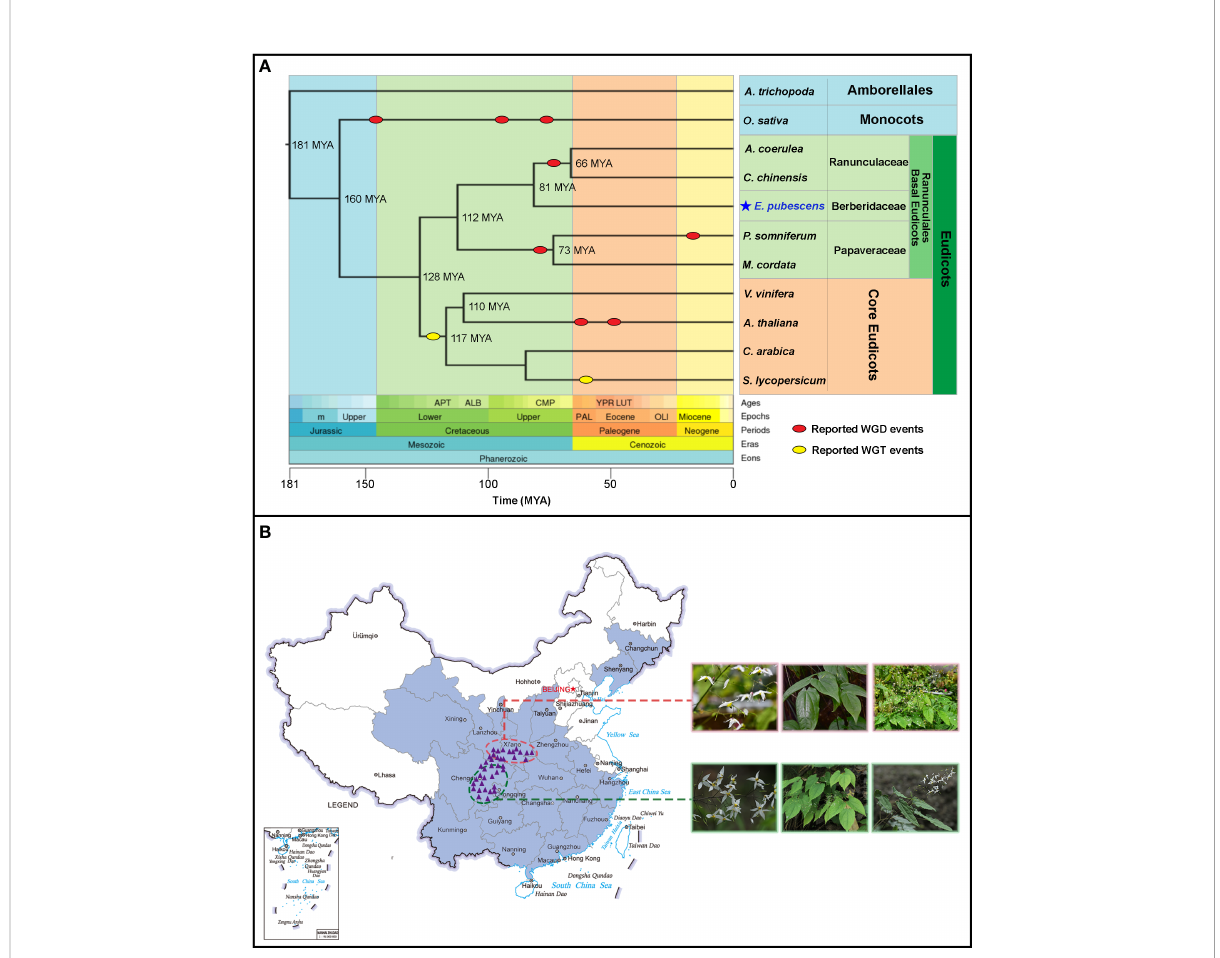
FIGURE 1 The phyologentic position of E . pubescens from Timetree website and the geographical distributions of Epimedium and E . pubescens in China. (A) Timetree of selected taxonomic groups in angiosperm. Whole Genome Duplication (WGD) events (red oval) and Whole Genome Triplication (WGT- g ) events (yellow oval) were shown on the Timetree; the divergence times among different taxonomic groups on the phylogenetic tree were predicted by Timetree online services (http://www.timetree.org/); hierarchy classi fi cations of taxonomic groups was highlighted with different colors on the right of Timetree, based on Angiosperm Phylogeny Group IV (APG IV). (B) Geographical distributions of Epimedium and E . pubescens in China. The purple line delimited the border of China, the light blue line delimited the border of Chinese coast. The geographical distributed area of Epimeidum was highlighted in cyan color on the map of China; the distribution areas of E . pubescens were indicated with purple triangles and split into two groups circled with red and green dash lines respectively (the geographical locations were provided in Table S2 and sampling details were described in Supplemental Information). Two E . pubescens groups possessed different morphological features, including fl owers, young leaves, and whole